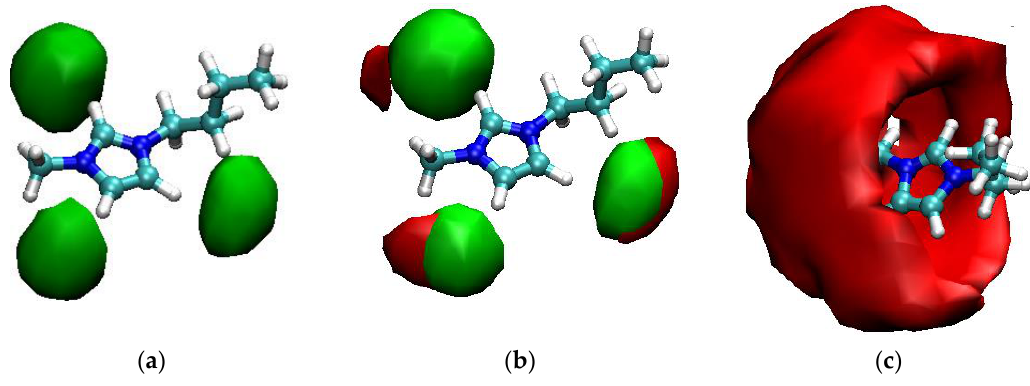
Figure 3. The spatial distribution functions (SDF) of the probability of finding the chloride anion (green) and/or water oxygen (red) around the imidazolium cation for: ( a ) The pure ionic liquid (IL) system, iso-contour value is eleven times higher than in the bulk; ( b ) the [C 4 C 1 im]Cl/water mixture with x IL = 0.50, iso-contour value for the chloride (green) is 9.6 times the bulk value, for the water oxygen (red) is seven times the bulk value; ( c ) the [C 4 C 1 im]Cl/water mixture with x IL = 0.01, the iso- contour value is for a probability density thirty-two times the bulk value.